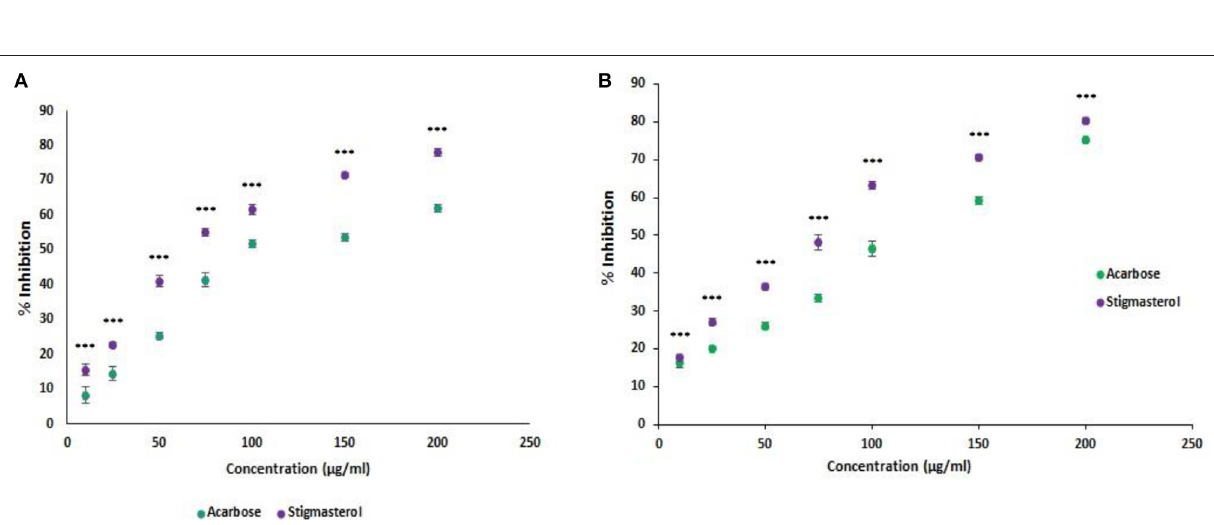
FIGURE 3 | (A) Alpha-amylase inhibition assay of the stigmasterol. The result shows that the alpha-amylase inhibition activity increases with the concentration of the stigmasterol, and the activity was higher than the control acarbose. (B) Alpha-glucosidase inhibition assay of the stigmasterol. Error bars indicate standard deviations, significance *** P <